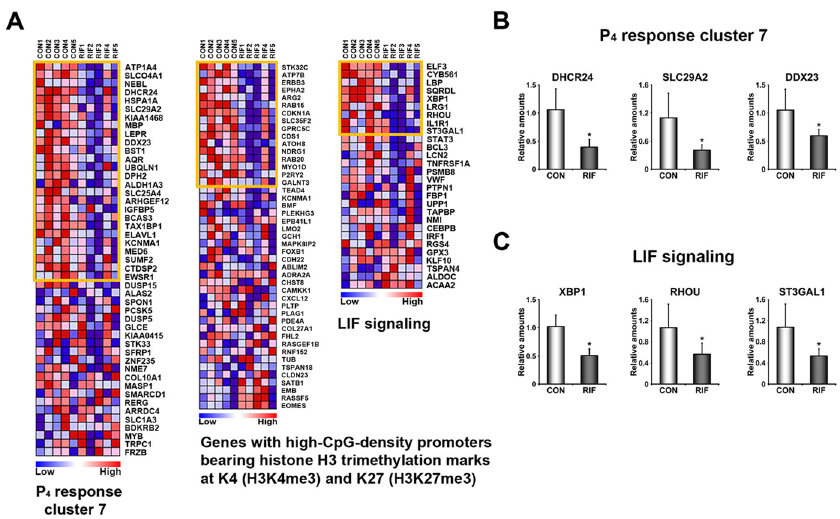
Fig 2. Dysregulated signaling pathways in the endometrium of patients with RIF. A) Heatmaps of representative gene sets that are aberrantly regulated in the endometrium of patients with RIF listed in Table 1. Genes within the orange boxes are leading characters for building enrichment scores in CON. The color spectrum from blue to red indicates low to high expression. B-C) Validation of systemic alteration of genes in these gene sets with realtime RT-PCR. CON and RIF represent endometrium of healthy fertile women and patients with RIF, respectively. * , p <